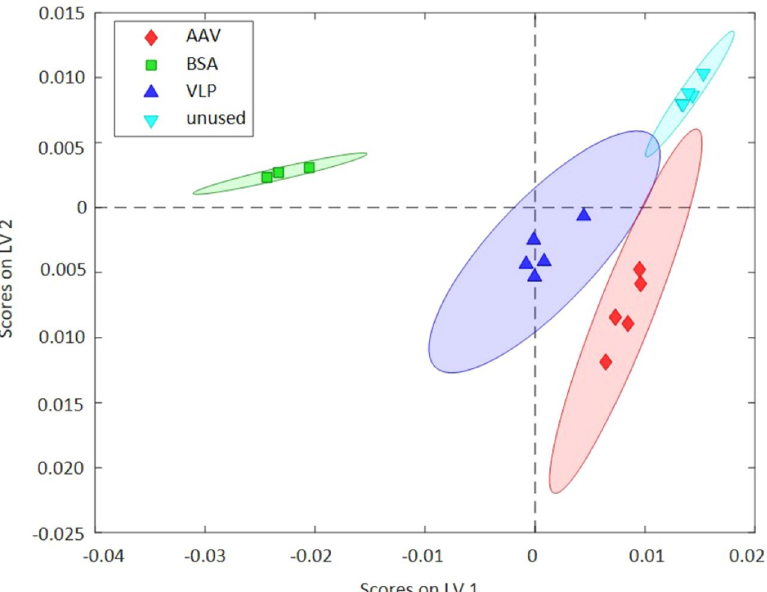
Figure 4. Scores plot of PLS-DA evaluation comparing four classes of face masks via IR-ATR spectroscopy. The model covers 98.90% of total variance and is based on three LVs. Unambiguous classification of differently contaminated protective face masks also vs. untreated masks is clearly